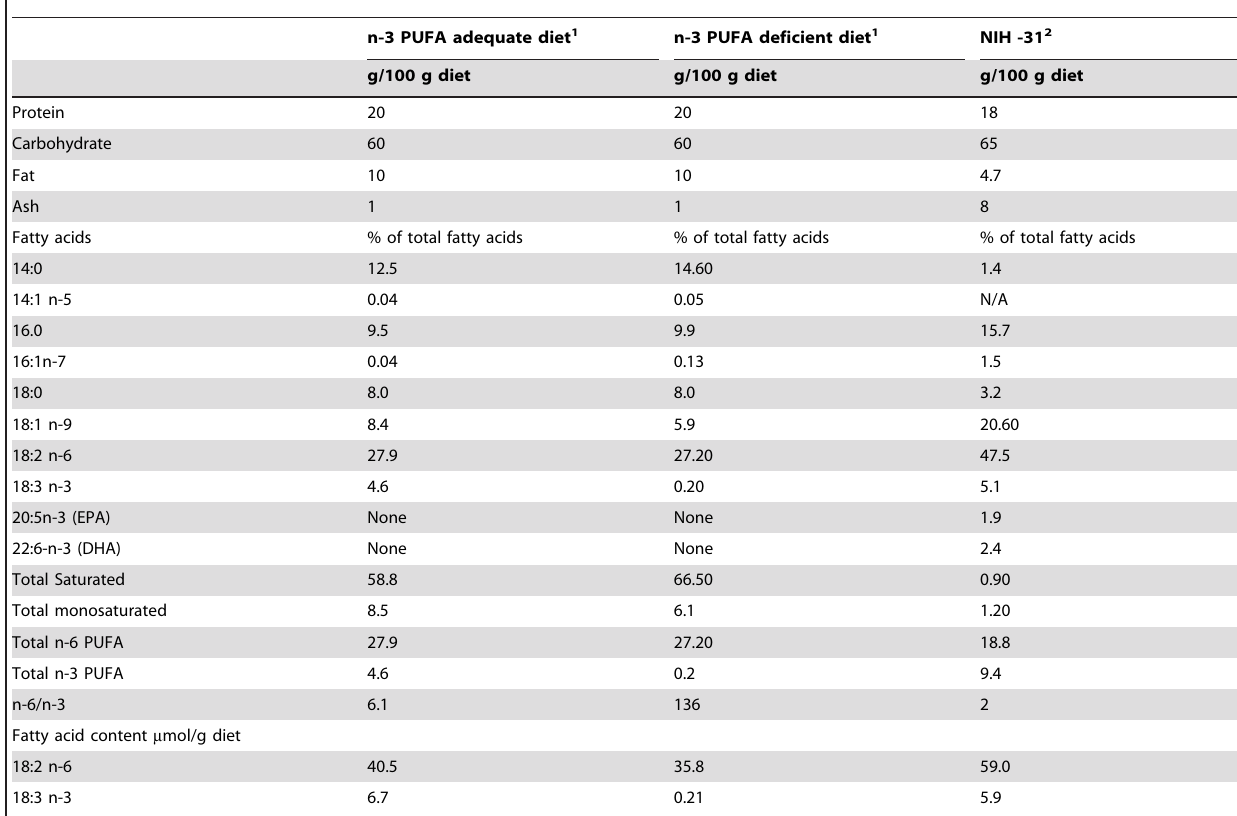
Table 1. Dietary compositions of n-3 PUFA adequate, n-3 PUFA deficient and NIH-31